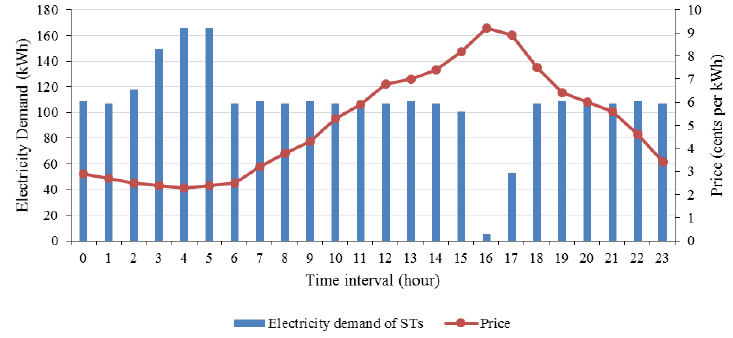
Figure 10. Total electricity demand of STs (including ACS and PPS#3, 4 and 5) during each time interval.